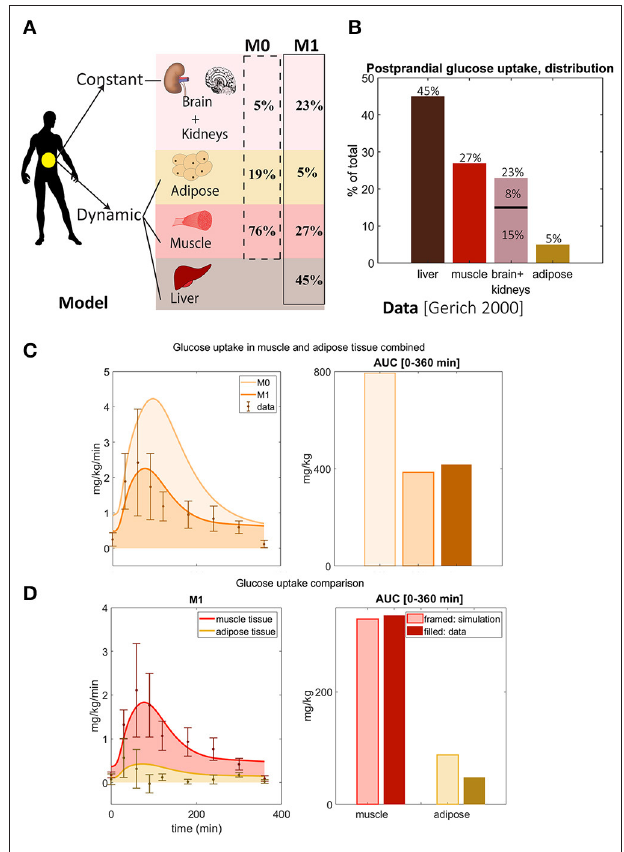
FIGURE 2 | Updated distribution of glucose uptake among tissues. (A) In model M1, liver is added, the amount of glucose utilization in muscle and adipose is reduced, and the uptake that is constant during a meal of other tissues is increased compared to the original M0 model. Note that there is no glucose uptake in the liver in M0. (B) Glucose distribution among organs observed in data from Gerich (2000). Note that the data shows that the liver is the largest source of glucose uptake. (C) Glucose uptake in muscle and adipose tissue combined for M1 and M0. In M1, parameter U ii was changed, and parameters part m , part f , and part l were added and chosen to reflect the data of total glucose uptake in (B) . The area under the curve for M0 is higher than seen in data from Frayn et al. (1993) and Coppack et al. (1996), and M0 is thus rejected. M1 correctly predicts total glucose uptake based on the independent data from Frayn et al. (1993) and Coppack et al. (1996). (D) Comparison between model M1’s predictions of adipose and muscle glucose uptake with new data not used for parameter estimation (Frayn et al., 1993; Coppack et al., 1996). M1 correctly predicts independent data for muscle tissue, while it slightly over-predicts independent data for adipose tissue due to timing